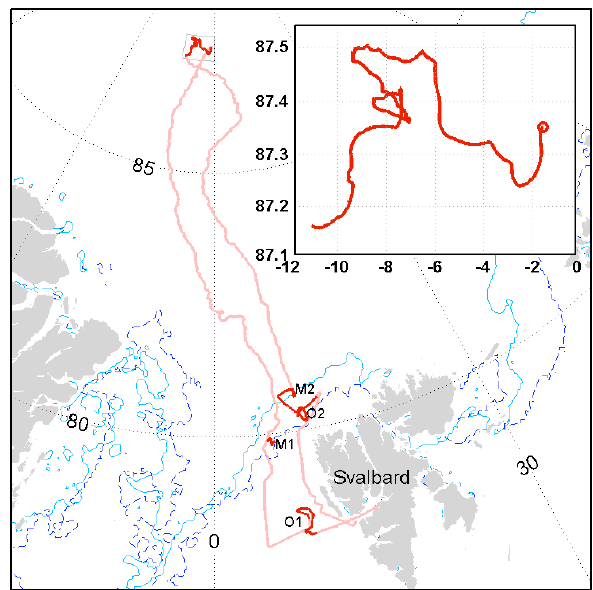
Fig. 1. Map of the ASCOS cruise track (pink) with ice-drift period Figure 1. Map of the ASCOS cruise track (pink) with ice-drift period (PI-drift) highlighted (red) 3 (PI-drift) highlighted (red) and (inset) shown in detail, with the start of the drift marked by the circle. The left-hand part of the track and (inset) shown in detail with the start of the drift marked by the circle. The left-hand part of 4 shows the initial northward track, while the right-hand track shows the track shows the initial northward track while the right-hand track shows the southward, return 5 the southward, return track. Convoluted track lines in open water, OW (O1 and O2), and at the ice edge, MIZ (M1 and M2), are as- track. Convoluted track lines in open water, OW (O1 & O2) and at the ice edge, MIZ (M1 & M2) 6 sociated with shorter sampling stations. The dashed light-blue line illustrates the ice edge at the time of entry and the darker-blue line are associated with shorter sampling stations. The dashed light blue line illustrates the ice edge at 7 at the time of the time of entry and the darker blue line at the time of exit. 8